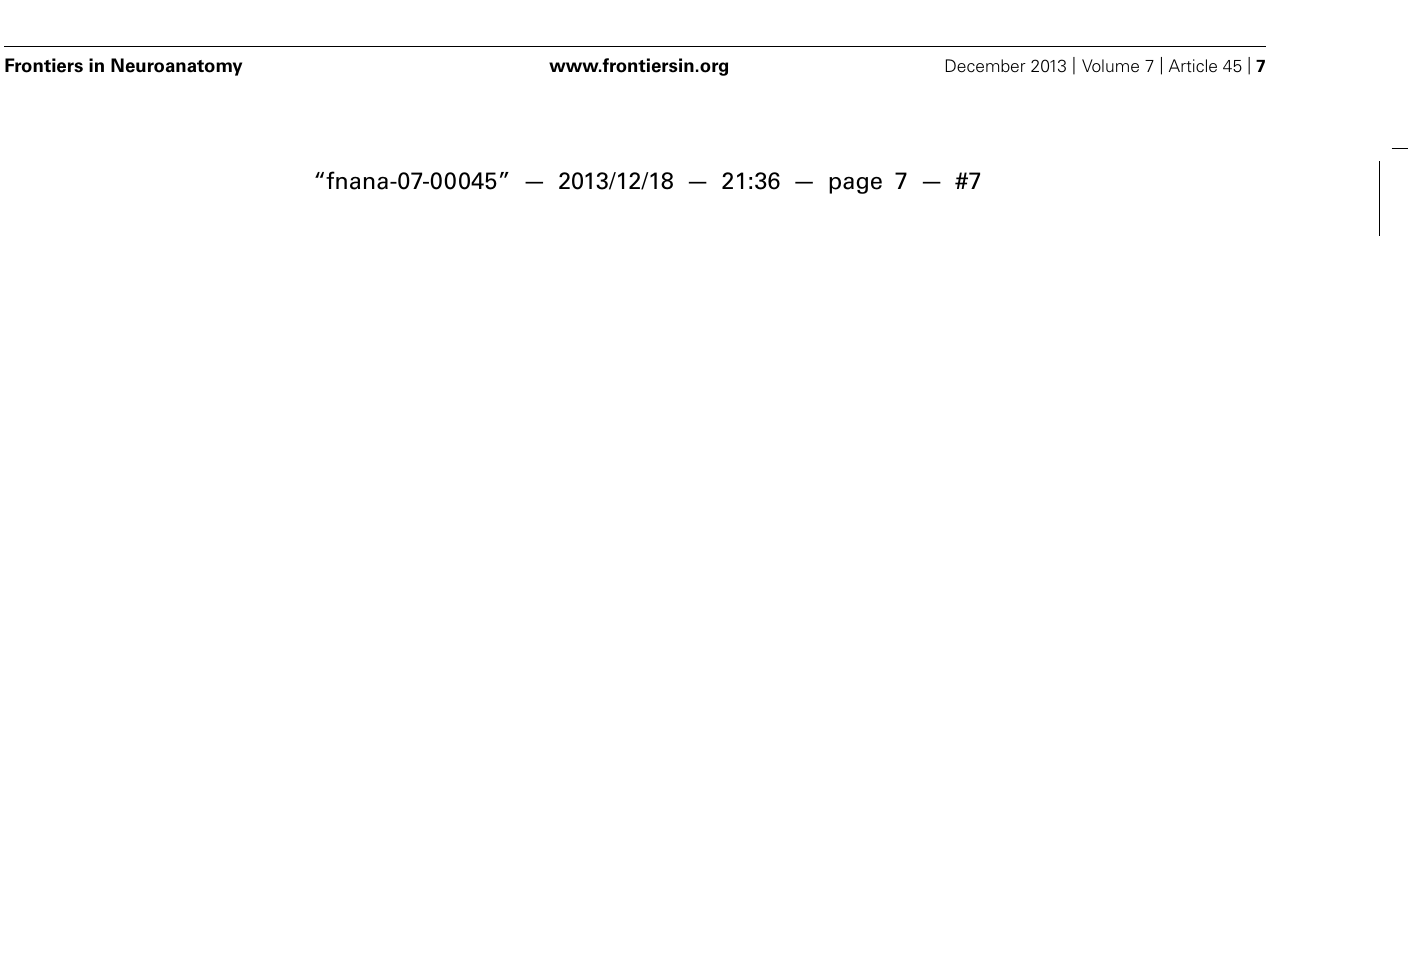
(red); mcp, middle cerebellar peduncle (green); sm, stria medularis (blue); st, stria terminalis (yellow) together with the caudate putamen (CPu; light green) cerebellum (CB; green), and hippocampus (H; light blue). Scale bar = 1